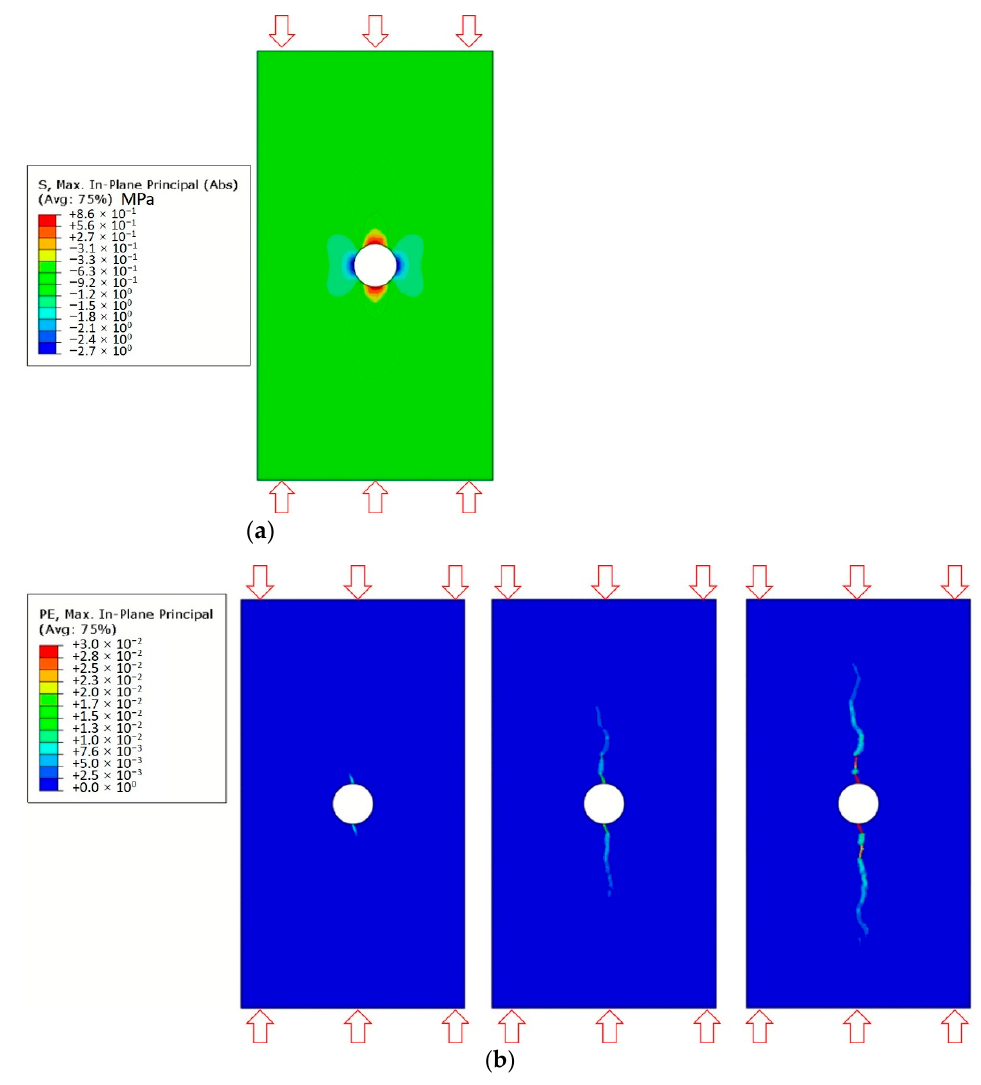
Figure 19. Simulated ( a ) stress concentration at the edge of a circular hole on a compressive loaded plate and ( b ) crack initiation and propagation process on a compressive loaded plate.